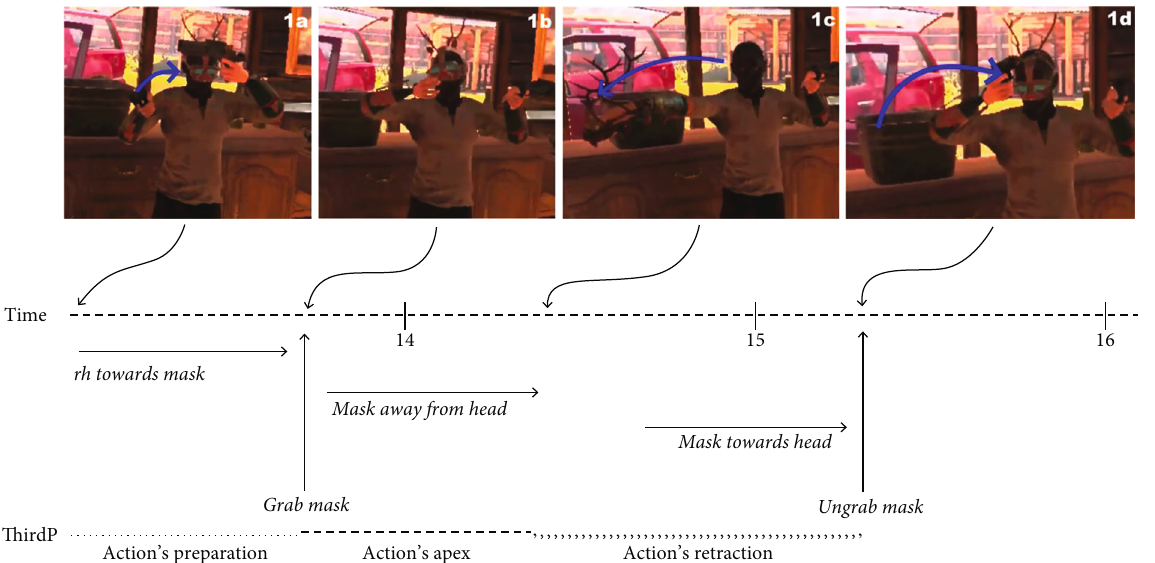
Figure 11: Removing and reequipping the mask. “ This is how you remove the mask ” . Time in